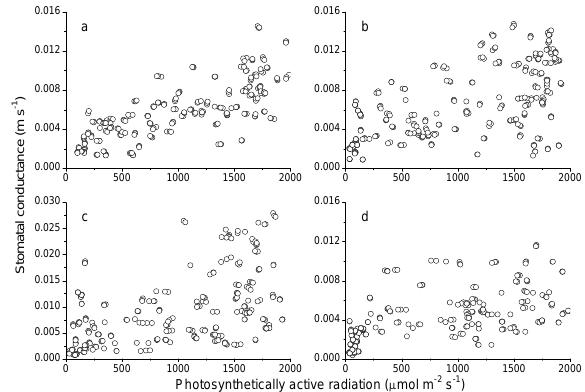
Fig. 2. Response of stomatal conductance to vapour pressure deficit at the four levels in the maize canopy on DOY 130 (a) , DOY 162 (b) , DOY 195 (c) , and DOY 229 (d) , respectively. F03 1